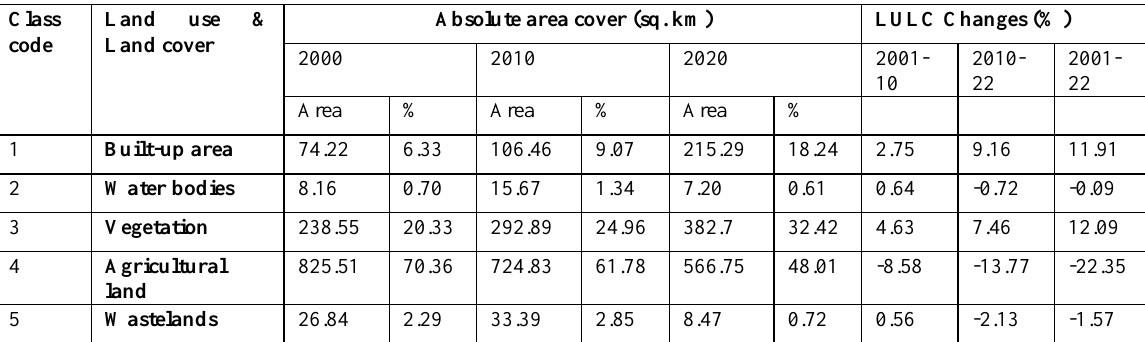
Table 3. Area under different LULC in Bhubaneswar from 2001 to 2022